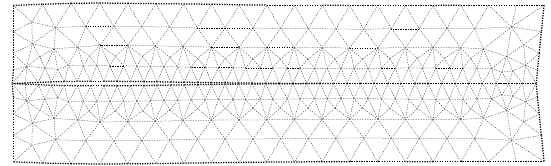
Figure 6.5 . Deformed configuration of the two viscoelastic bodies for µ = 0 . 15ns/m 2 and η = 0 . 075ns/m 2